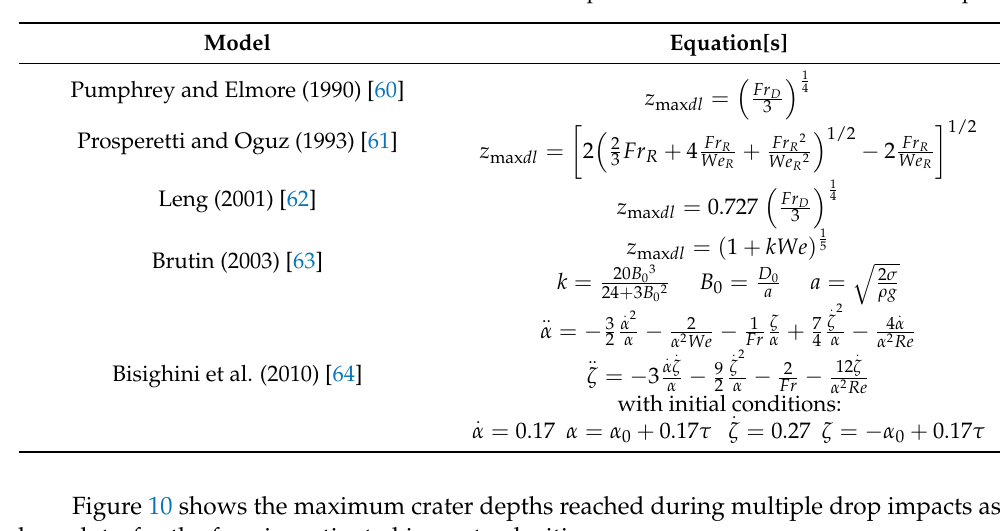
Table 2. Literature models for the dimensionless crater depth evolution and maximum crater depth.